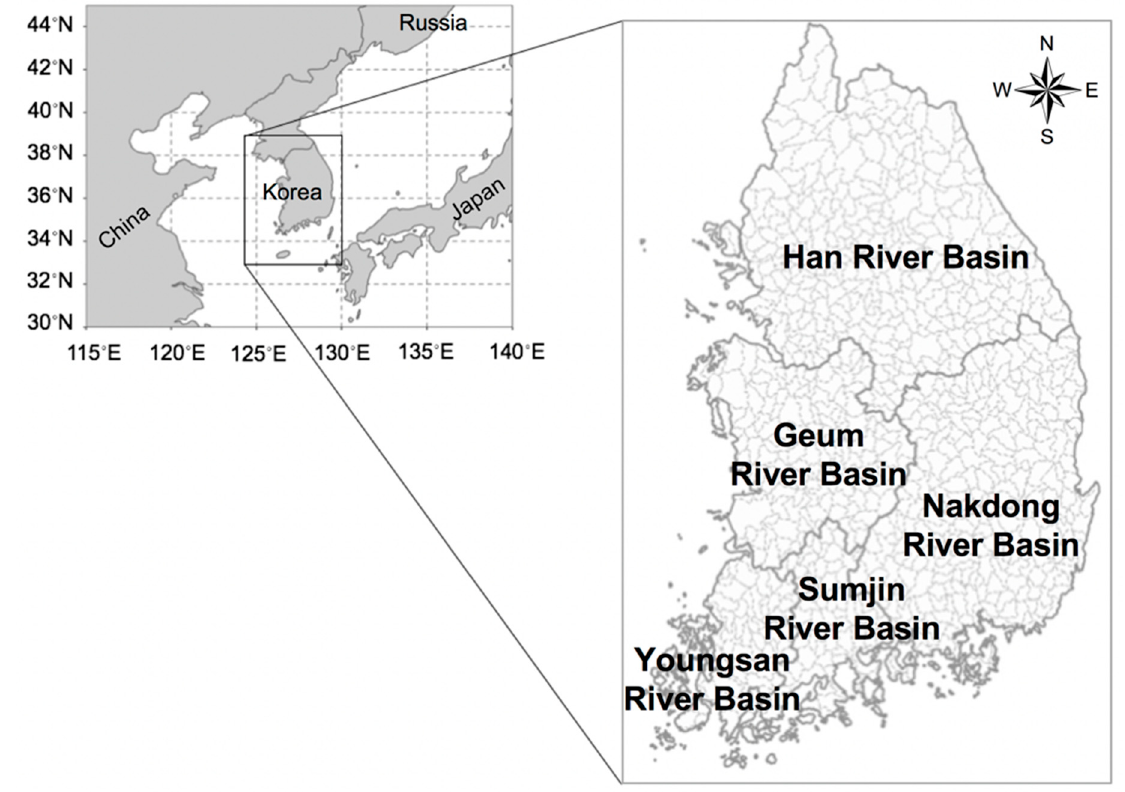
Figure 1. Geographical location of the five major river basins and the 849 sub-basins in Korea.